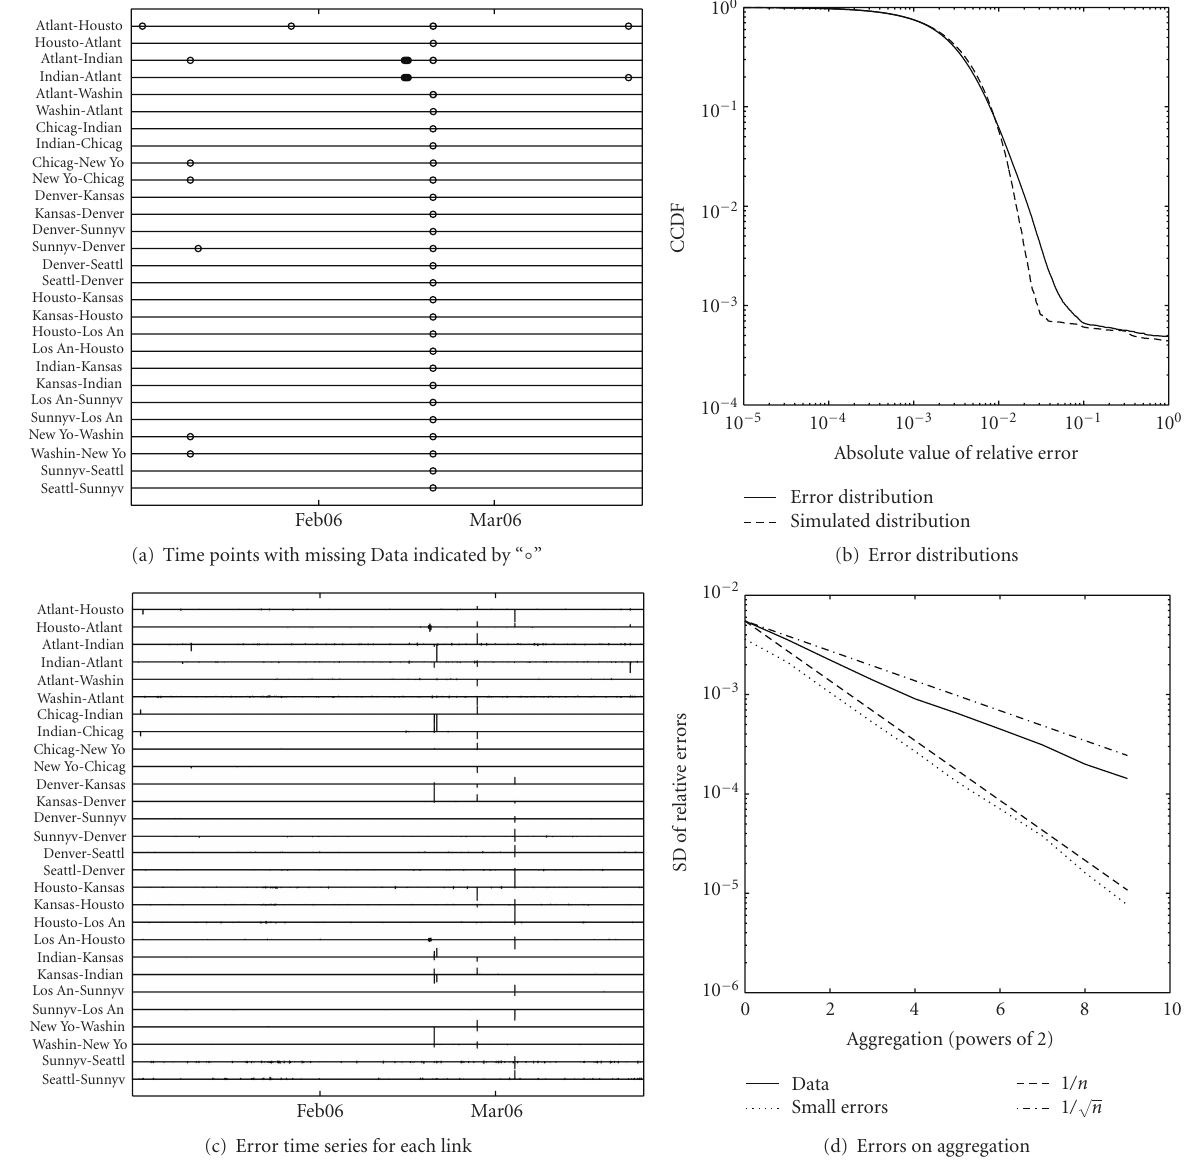
Figure 2: SNMP errors and missing